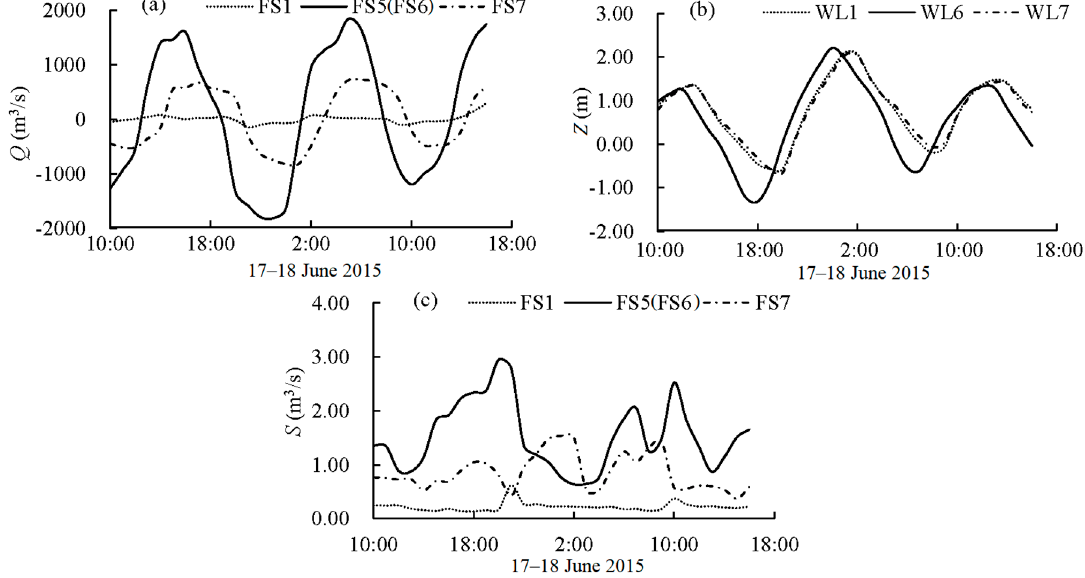
Figure 7. Boundary conditions with measured data: ( a ) Flow discharge ( Q ); ( b ) Water stage ( Z ); ( c ) S .